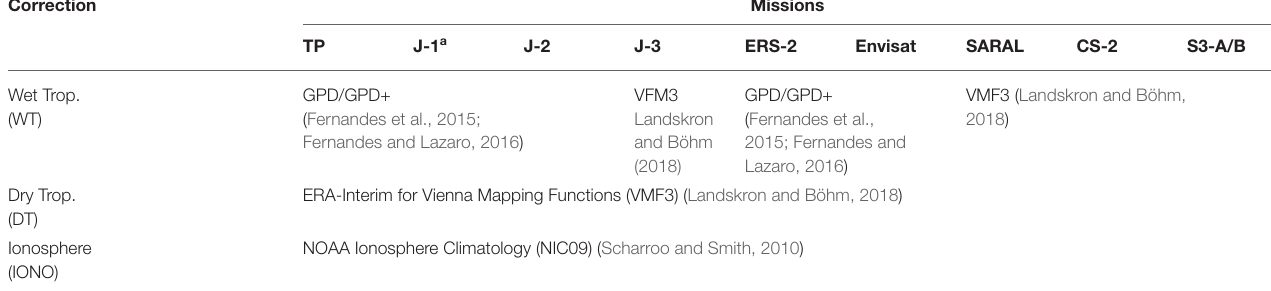
TABLE 1 | Altimeter corrections/parameter applied to the along-track processing.